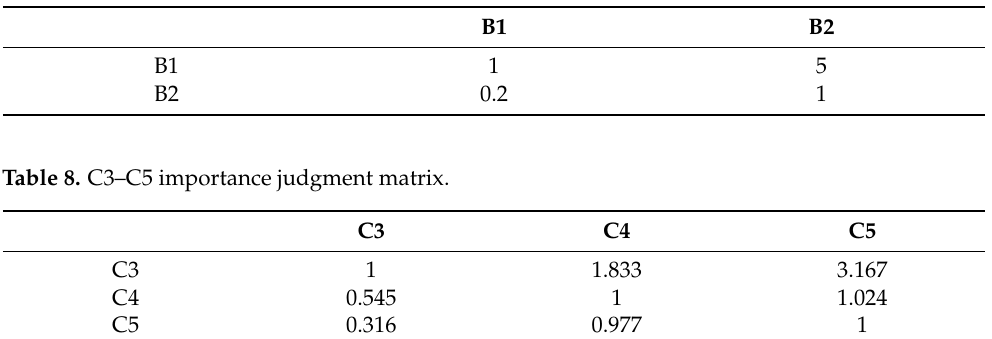
Table 7. C1–C2 importance judgment matrix.